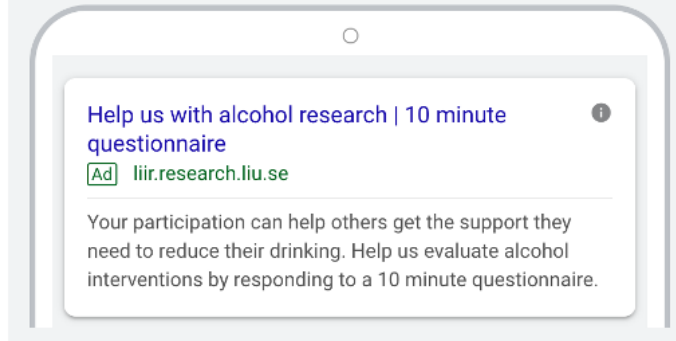
Figure 1. Example of online advertisement used to recruit trial